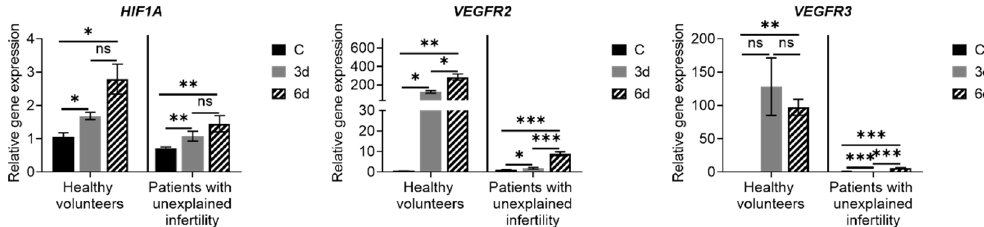
Figure 6. Expression of angiogenesis-related genes. Results are presented as mean ± standard deviation. In the group of healthy volunteers n = 2, in patients with unexplained infertility n = 4. C—control cells, 3d—cells after 3 days of culture in decidualization medium, 6d—cells after 6 days in differentiation medium. * p ≤ 0.05; ** p ≤ 0.01; *** p ≤ 0.001, ns—not statistically significant, based on t -test (Holm–Sidak method).